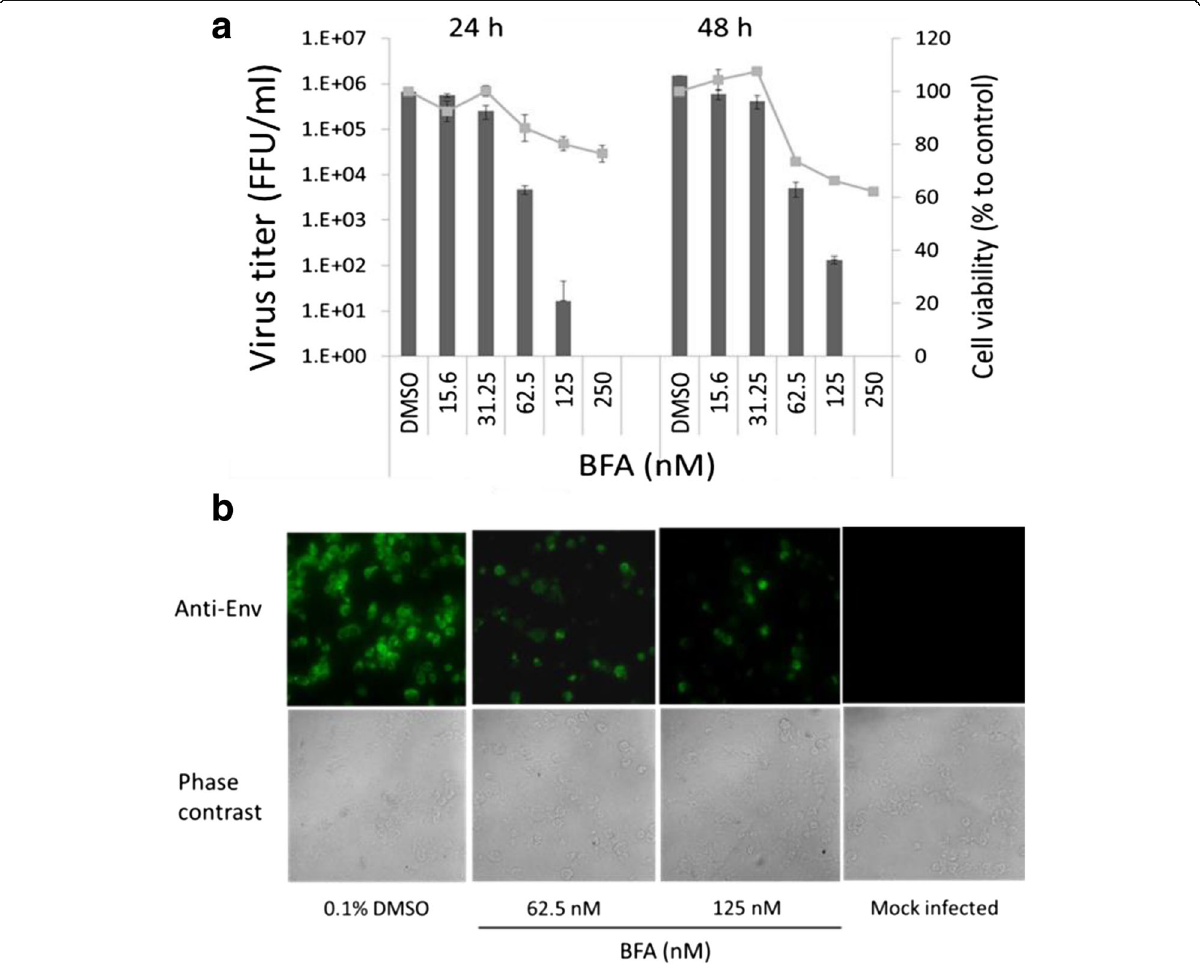
Fig. 2 Identification of anti-DENV activity of brefeldin A by virus titration and immunofluorescence assay or IFA. a Vero cells in 96-well plates were infected with DENV at an MOI of 0.5 in the presence of compound at indicated concentrations or 0.1% DMSO. After 24 h or 48 h incubation, ICF was harvested and virus titer was determined by focus assay as described in the “ Materials and methods ” section. In separated experiments, Vero cells in 96-well plates were treated with the compounds at different concentrations without virus infection. After 24 h or 48 h incubation, cell viability was determined by MTT assay as described in the “ Materials and methods ” section. b Vero cells in 24-well plates were infected with DENV at an MOI of 0.5 and added with the compounds at indicated concentrations. After 48 h incubation, the cells were recovered, spotted onto glass slides, and stained with 12D11 monoclonal antibody which react to viral envelope replication was strongly inhibited (Fig. 2b). Taken together, concentration (IC ) value and CC of BFA at 48 h post- 50 50 these results demonstrated BFA isolated from fungal infection were 54.6 ± 0.9 and 2000 nM, respectively strain Penicillium sp. FKI-7127 as an inhibitory agent (Table 1). In line with virus titration results, IFA staining against DENV. showed significantly decreased viral protein level by BFA is a fungal secondary metabolite which was first addition of BFA at concentrations of 62.5 and 125 nM (as isolated from Penicillium decumbens [12]. BFA has indicated by green fluorescence) suggesting that DENV-2 Table 1 Antiviral activity of BFA against DENV-1 to 4, ZIKV, and JEV in Vero cell IC 50 (nM) a